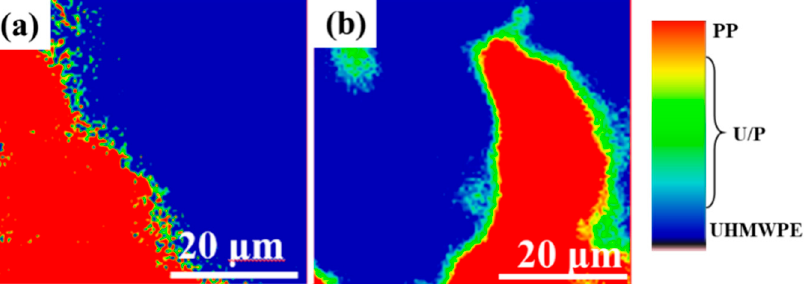
Figure 5. Raman mapping of ratio of the peak intensities (I 804 /I 1295 ) for UHMWPE/PP under different processing methods: ( a ) by shear flow; ( b ) by elongational flow.